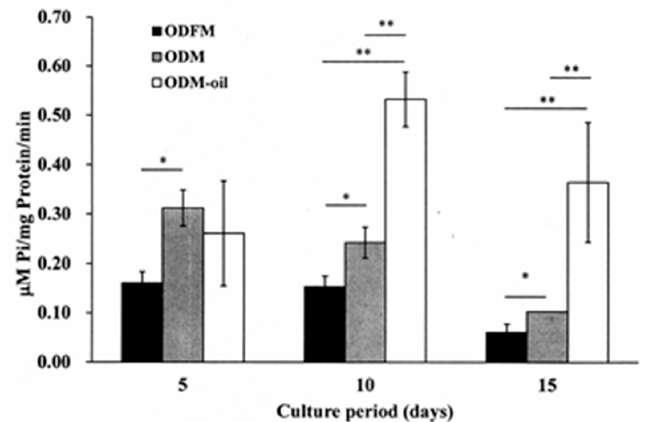
Figure 5. Odontogenic differentiation capacities of DPSCs as assessed by Alizarin red S staining after 14-day culture period. ( a ) No mineralized nodule deposition is observed when the DPSCs are cultured in general medium. ( b ) Following odontogenic medium induction, observable mineralized nodule deposition occurs. ( c ) Following co-culturing with odontogenic medium and S. mukorossi seed oil, the DPSCs secrete more abundant mineralized nodules. ( d ) Quantification of the Alizarin red S staining results shows a significant difference between the ODM and ODM-oil groups (* p < 0.05). (Note ODFM: odontogenesis induction-free medium; ODM: odontogenesis induction medium; and ODM-oil: odontogenesis induction medium with S. mukorossi seed oil.). Scale bar for a , b and c denote 100 µm.